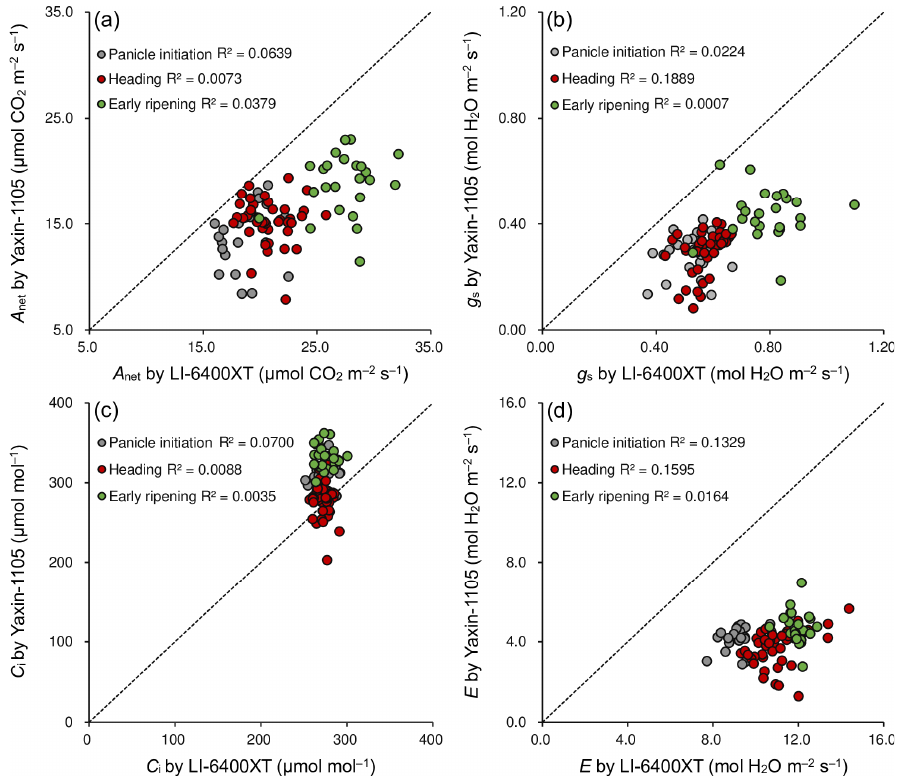
Figure 2. Coefficients of determination (R 2 ) between ( a ) net photosynthetic rate ( A net ), ( b ) stomatal conductance ( g s ), ( c ) intercellular CO 2 concentration ( C i ), or ( d ) transpiration rate ( E ) measured by Yaxin-1105 and LI-6400XT. The dashed line is 1:1